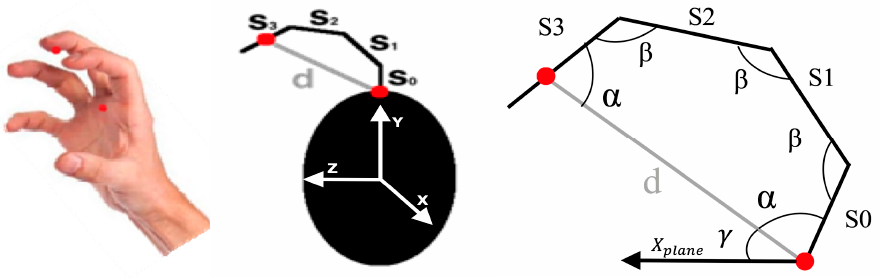
Figure 7. Modeling of palm to middle finger orientation.